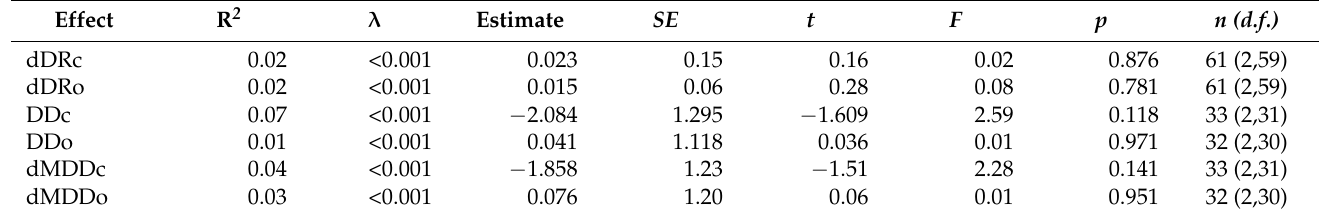
Table 1. Results of phylogenetic generalised least squares (PGLS) models for the relationship be- tween geographical range size and detrended diet richness residuals (dDR), diet diversity (DD) and detrended maximum diet diversity (dMDD) at class (c) and order (o) taxonomic ranks of Falconidae species.